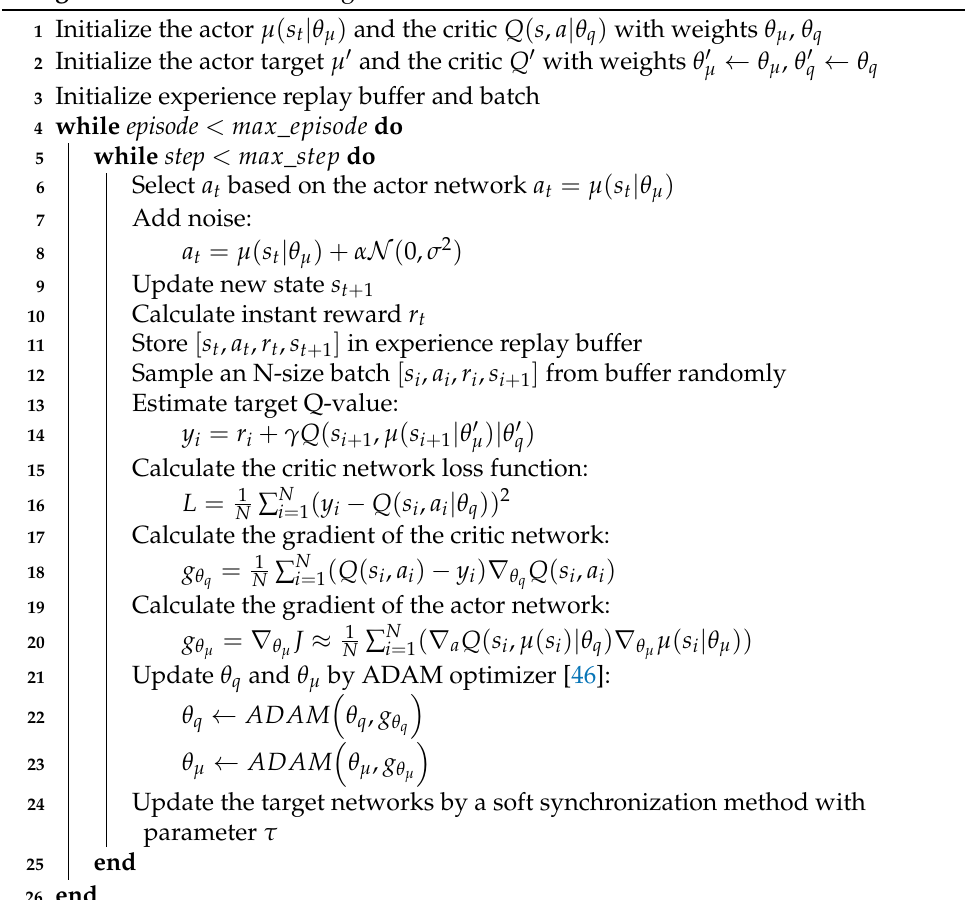
Algorithm 2: Task scheduling method based on